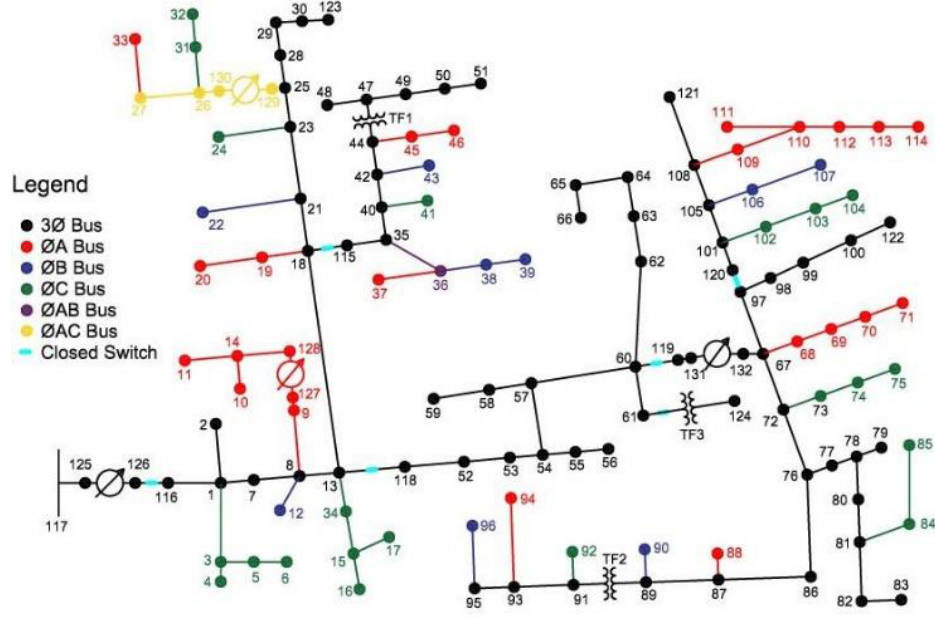
Figure 2. IEEE 123-Bus System